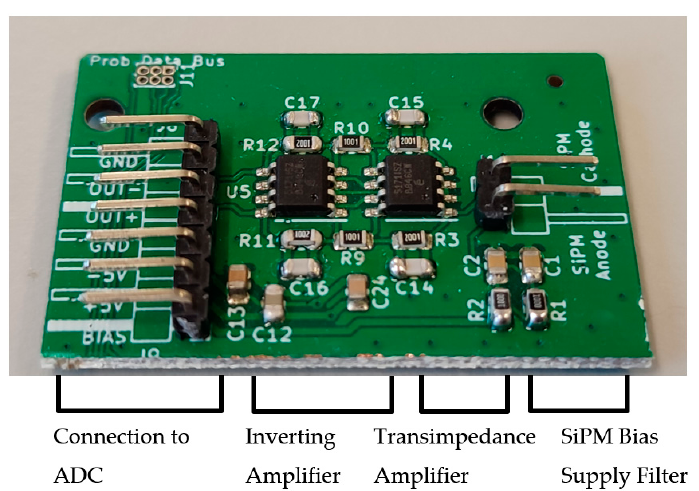
Figure 3. Picture of manufactured SiPM amplifier board labeled with key sections. The board measures approximately 28 by 42 mm.